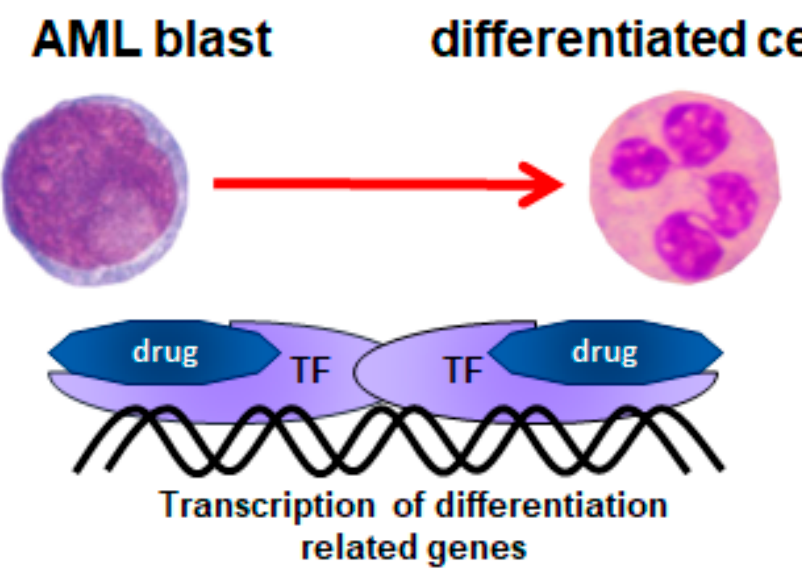
Figure Figure 1. The general idea of differentiation therapy. AML—acute myeloid leukemia; TF—tran- scription factor.